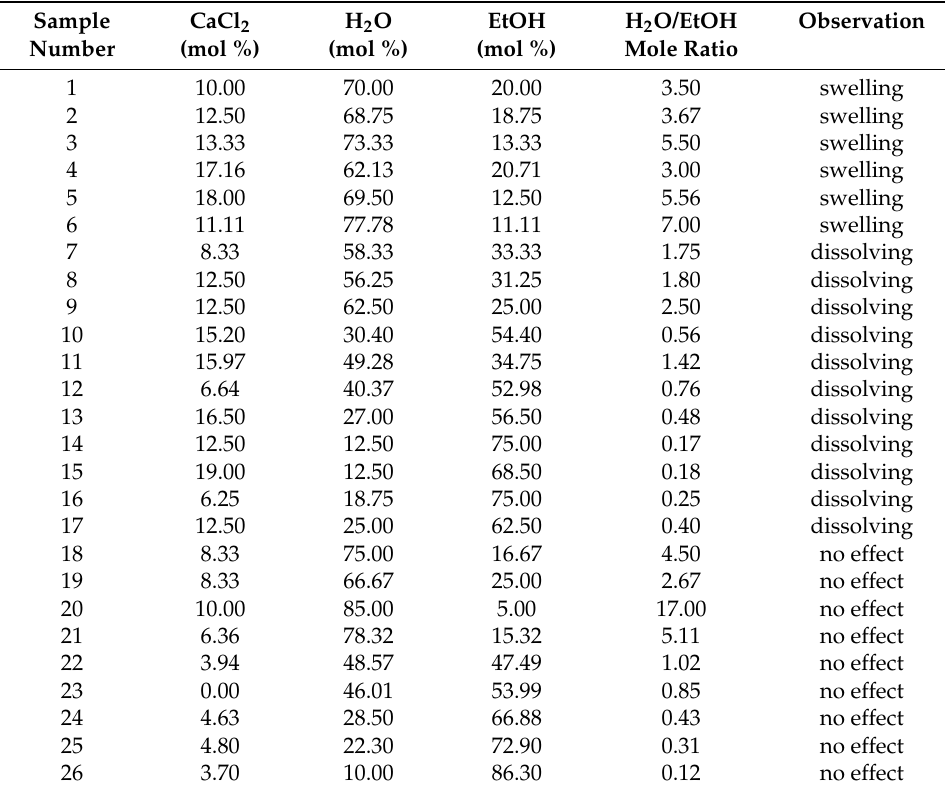
Table 1. Compositions of different solvents for the dissolving and swelling observation.